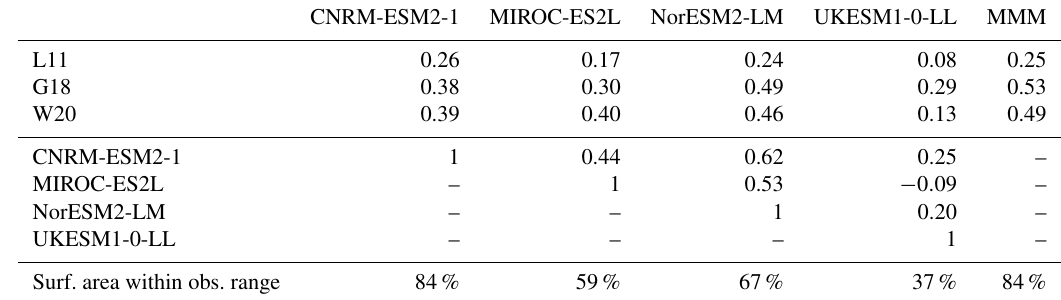
Table 4. Spatial correlation coefficients between L11, G18, and W20 and the models (first three rows) and between the individual models (rows 4–7), derived from the data displayed in Fig. 1. Last row: area fraction (%) within the range of L11, G18, and W20, i.e. fraction of oceans that is not with hatching in Fig. 1. See text for details about the observational range definition.